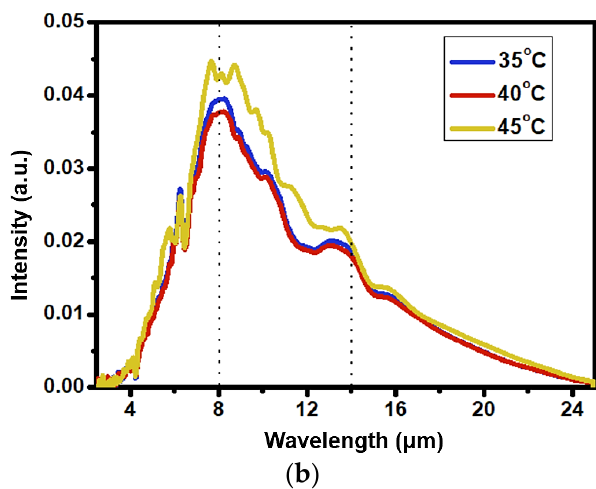
; ( b ) Far-infrared emission spectra ℃